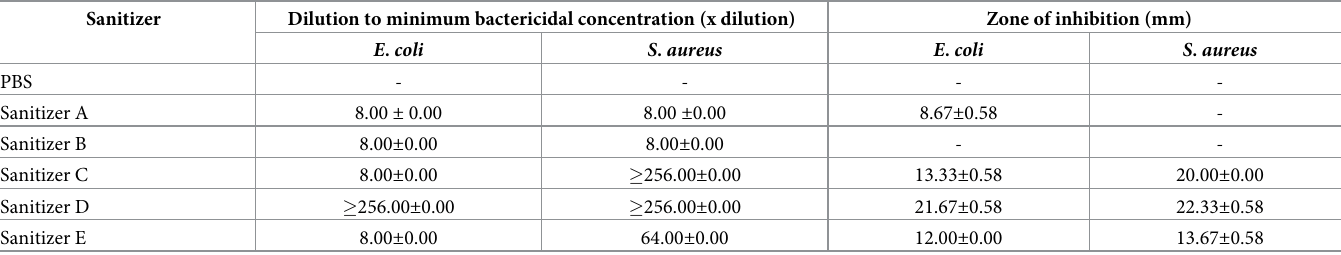
Table 2. Antibacterial potency assessment of various alcohol-based sanitizers using minimum bactericidal concentration and zone of inhibition. Sanitizer Dilution to minimum bactericidal concentration (x dilution) Zone of inhibition (mm) E . coli S . aureus E . coli S . aureus PBS - - - - Sanitizer A 8.00 ± 0.00 8.00 ± 0.00 8.67 ± 0.58 - Sanitizer B 8.00 ± 0.00 8.00 ± 0.00 - - Sanitizer C 8.00 ± 0.00 � 256.00 ± 0.00 13.33 ± 0.58 20.00 ± 0.00 Sanitizer D � 256.00 ± 0.00 � 256.00 ± 0.00 21.67 ± 0.58 22.33 ± 0.58 Sanitizer E 8.00 ± 0.00 64.00 ± 0.00 12.00 ± 0.00 13.67 ±